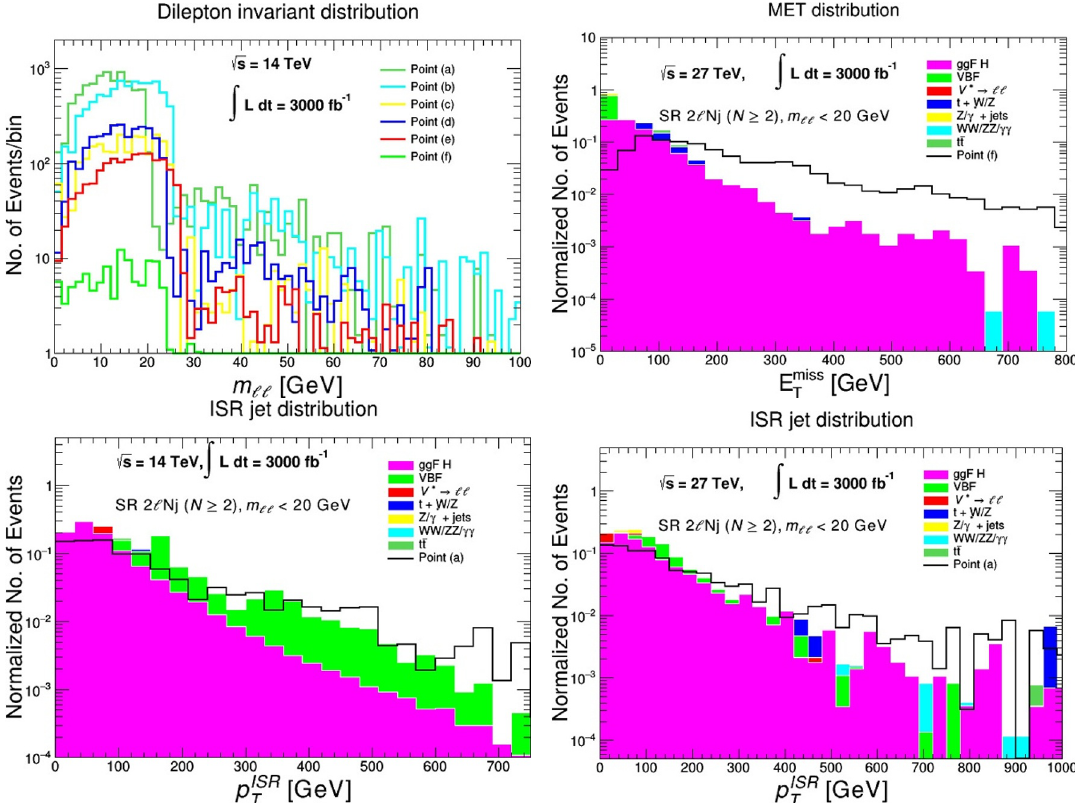
Figure 3 . Top panels: an exhibition of the reconstructed dilepton invariant mass, m ‘‘ , (left) for points (a)–(f) at 14 TeV and the distribution in MET (right) at 27 TeV for point (f). Bottom panels: an exhibition of the distributions in the ISR transverse momentum at 14 TeV (left) and 27 TeV (right) for benchmark